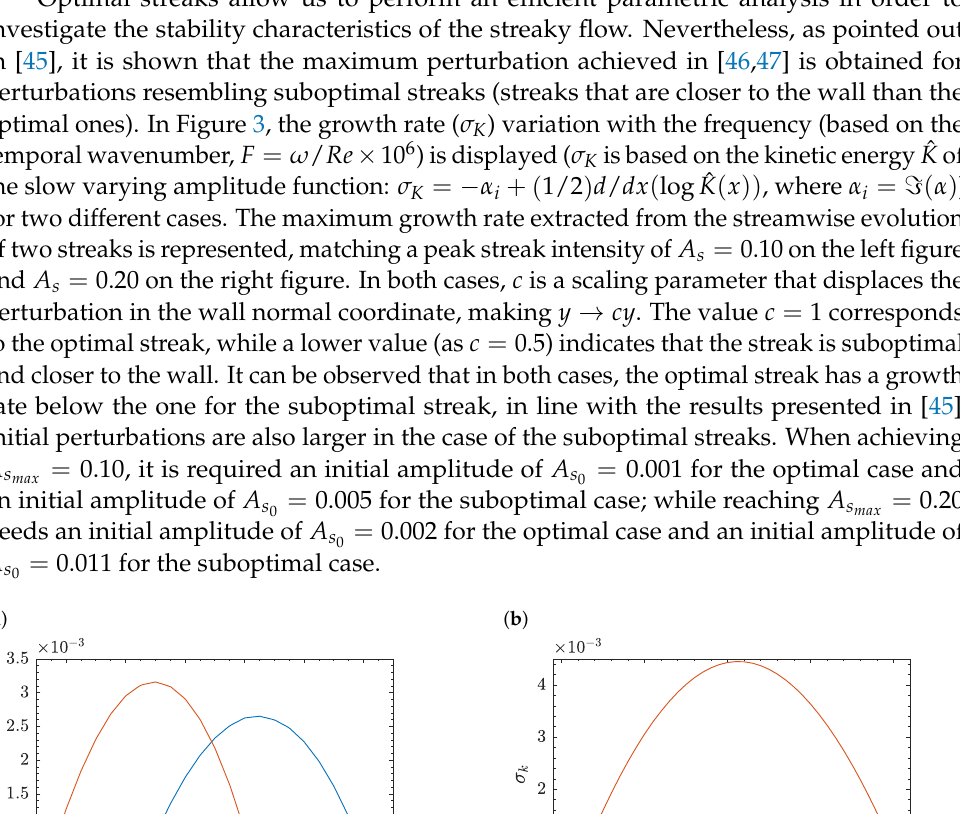
= 0.10 and ( b ) A s = max max